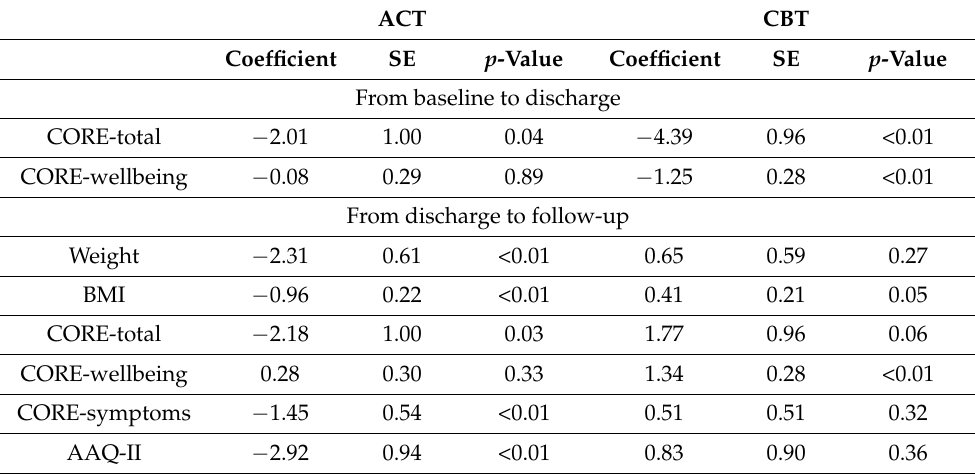
Figure 3. Changes over time in BMI, weight, and CORE-total. Table 5. Results of the simple slope analysis performed to assess differences between ACT and CBT in changes of the outcomes over